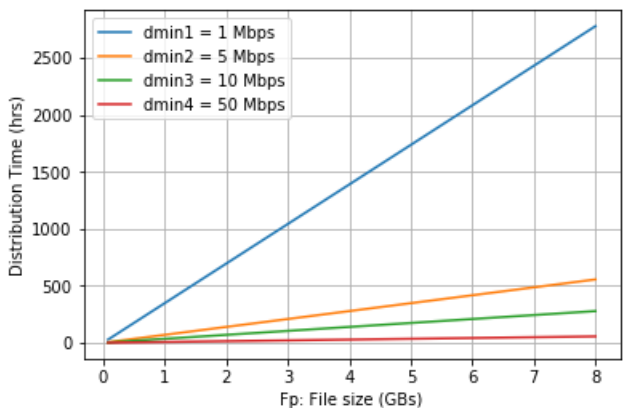
Figure 9. Distribution time when N = 10, M = 100.